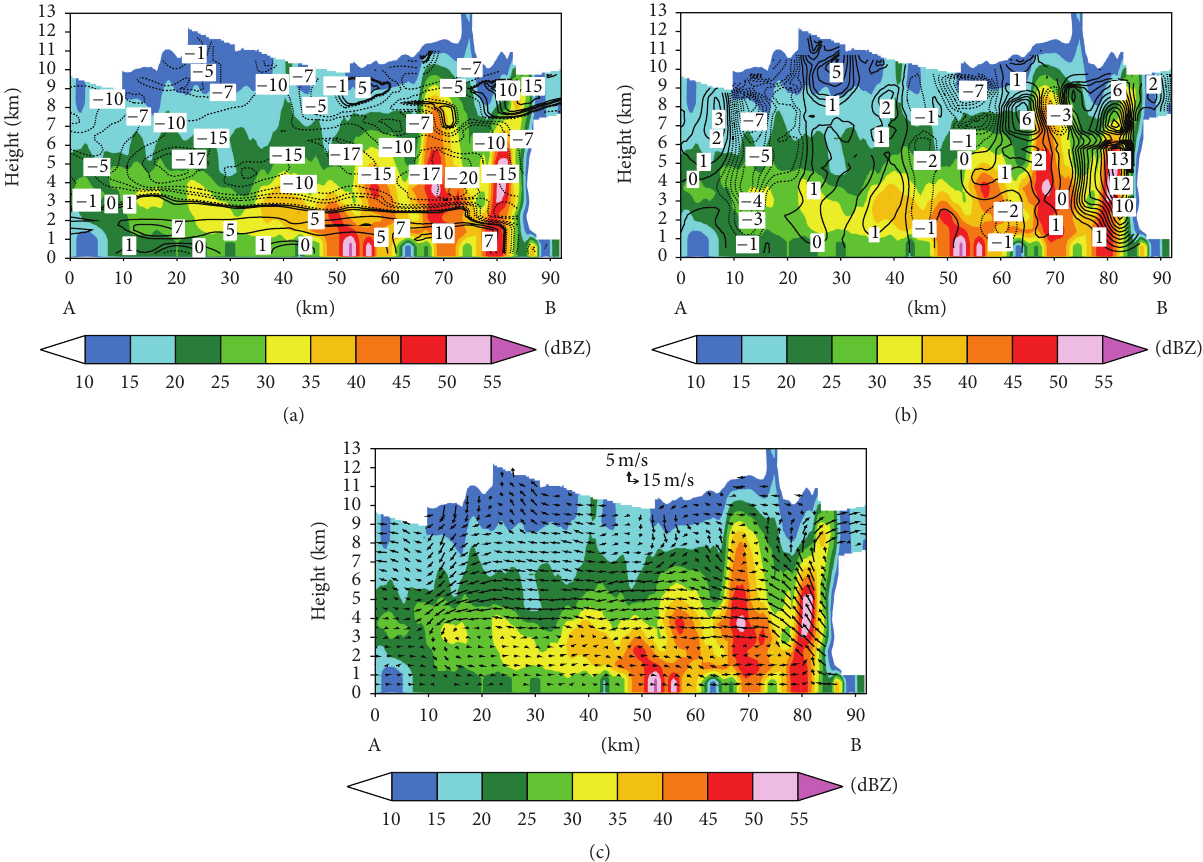
Figure 13: Reflectivity, the storm-relative horizontal air flow (a), the vertical velocity (b), and the storm-relative wind field (c) in the vertical cross-section perpendicular to the squall line (along AB in Figure